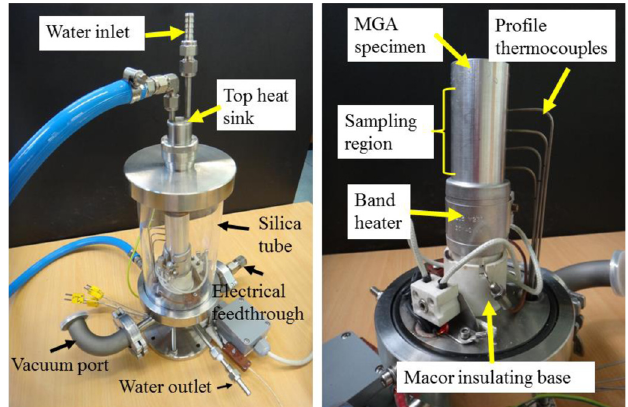
Fig. 2. MGA thermal gradient apparatus for neutron diffraction